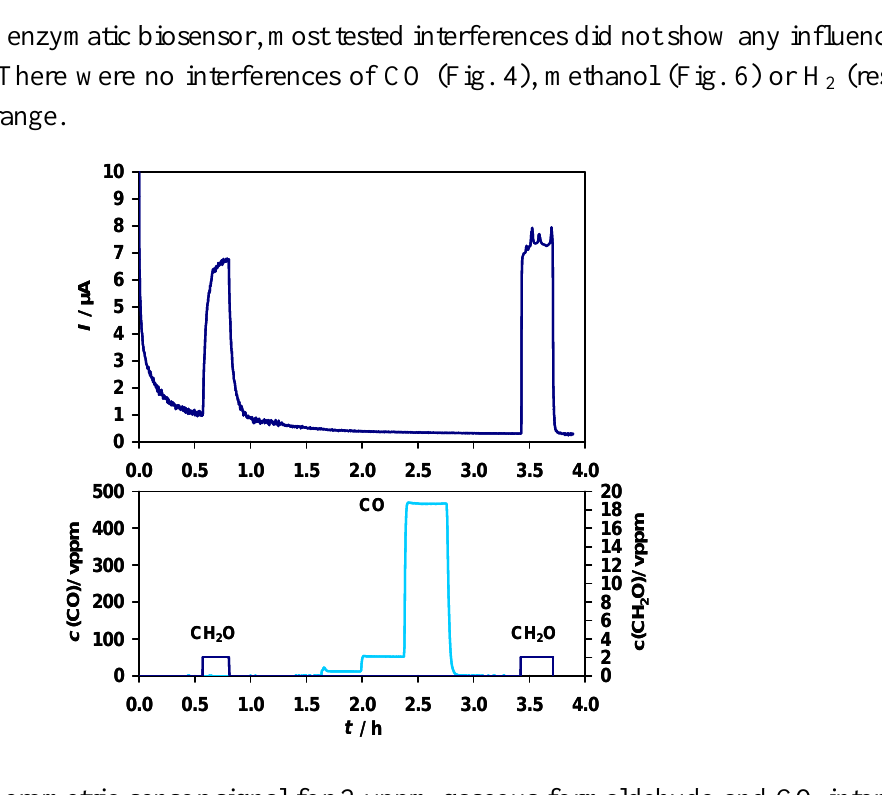
Figure 4. Top: Amperometric sensor signal for 2 vppm gaseous formaldehyde and CO interferences in the range of 0 - 467 vppm. Bottom: Test cycle concentrations of CO (left y-axis) and formaldehyde (right